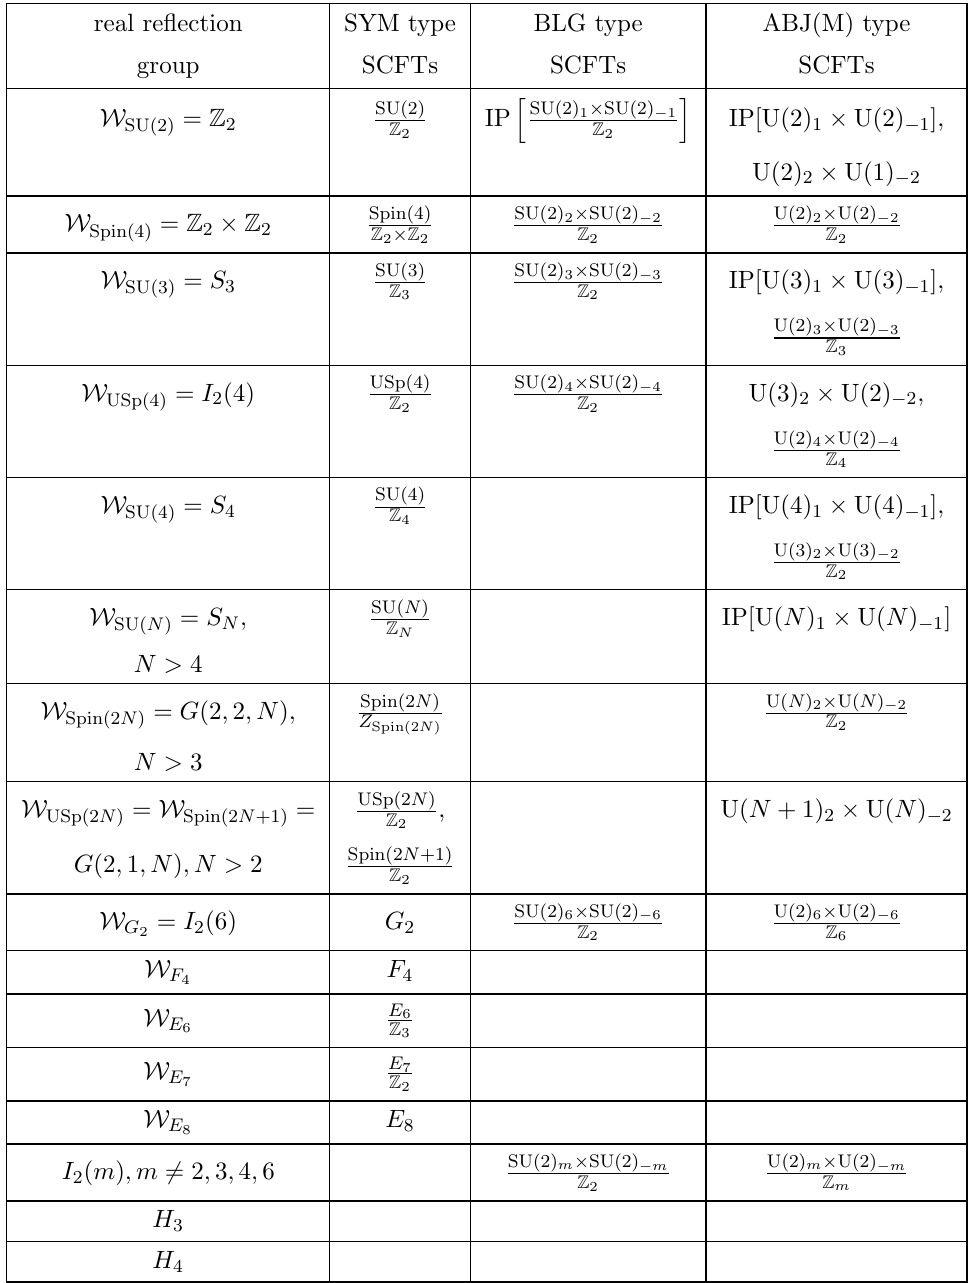
Table 1 . List of the real reflection groups and the = 8 SCFTs realizing them broken into three N categories: SYM type, BLG type or ABJ(M) type. Here only oldest SCFTs are listed. We use Z G for the Weyl group of G , and Z Spin(2 N ) for the center of Spin(2 N ), which is either Z 2 2 W × or Z 4 depending on whether N is even or odd. Also we use IP[ x ] for the interacting part of the SCFT x . I 2 ( m ), H 3 and H 4 are the non-crystallographic real reflection groups, as explained in the introduction. An empty entry implies no representative SCFT in this category. As noted in the text, there is by now some evidence that all theories in a given line in fact describe the same SCFT. There are no known = 8 SCFTs associated with the real reflection groups H 3 and H 4 , but we N have kept them in the table for